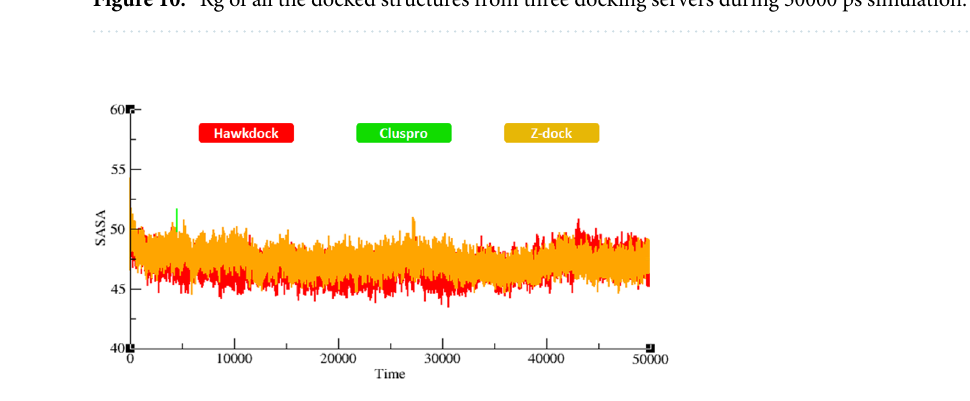
Figure 11. SASA of all the docked structures from three docking servers during 50000 ps